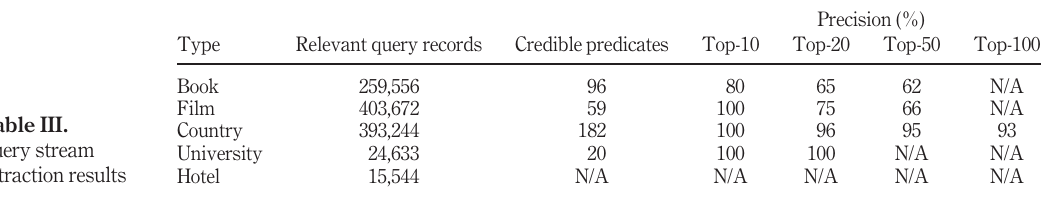
Table II. Existing KB extraction results